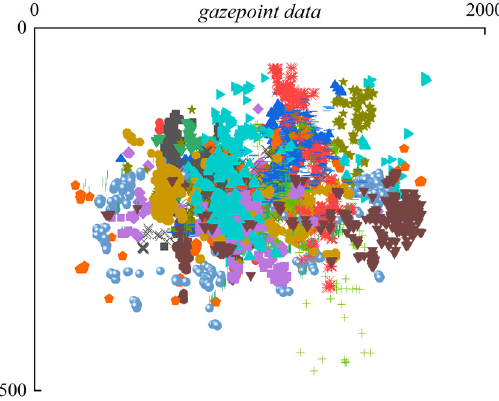
Figure 9. Example of the distribution of gaze points for different scene images.